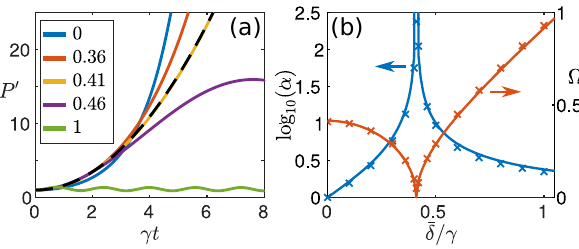
Figure 3: Nonexponential decay at EP of a 20 × 20 lattice with d = 0.54 λ . (a) P ′ (cid:1) e 2 ˜ υ t P , with the survival probability P (cid:1) ∑ of a single-photon excitation from initial steady state ̅̅ √ P (cid:1) − P (cid:1) 1 / 2 , for various δ / γ given in legend. Black dashed line I P gives the nonexponential behavior at the EP δ ≈ 0 . 41 γ of the corre- sponding two-mode model, dividing real-exponential and oscilla- tory, complex-exponential contributions. (b) α and Ω extracted from fi t of numeric decay (crosses) to Equation (13), and predicted from two-mode model (lines). The EP is characterized by diverging α and Ω →